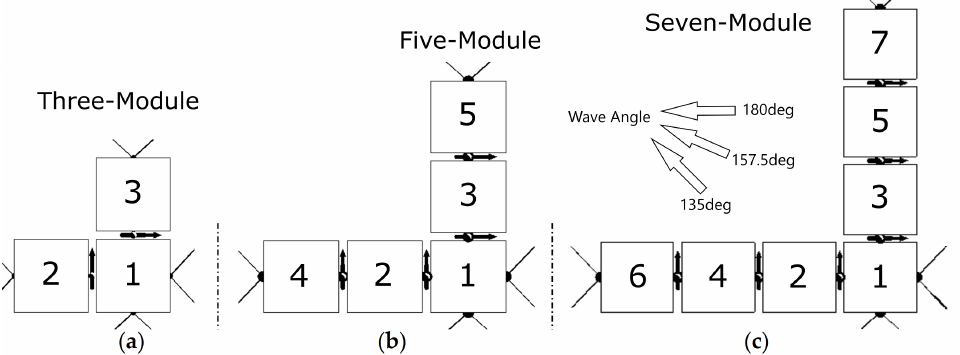
Figure 20. The three corner configurations considered for studying the sensitivity to incident wave angle: ( a ) the three-module case; ( b ) five-module case; ( c ) and seven-module